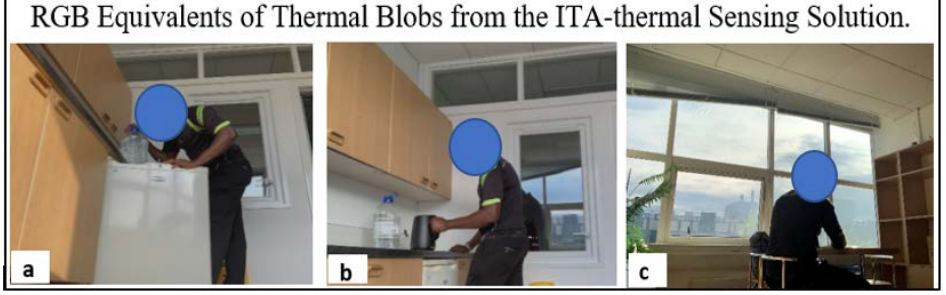
Figure 4. RGB equivalents of activities: ( a ) opening the fridge, ( b ) heating a hot kettle, and ( c ) having tea or coffee at the kitchen